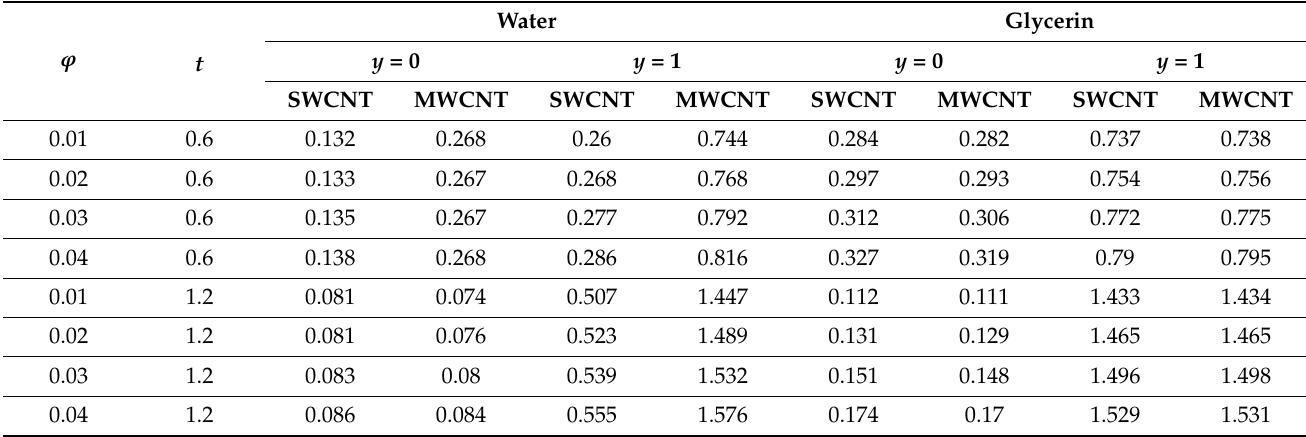
Figure 5. Comparison of velocities, temperatures and concentrations at t = 0.6. Table 2. Deviation of skin frictions for various values of ϕ